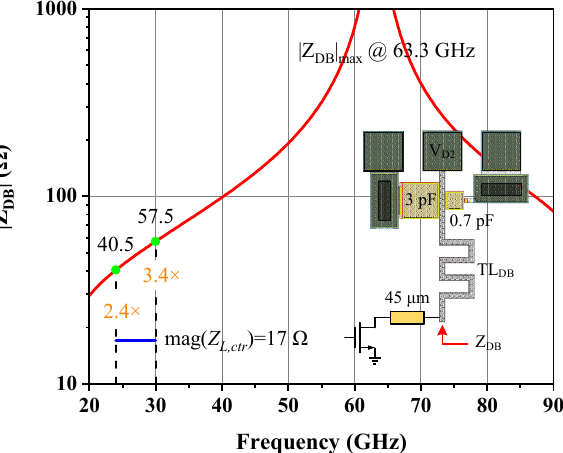
Figure 8. Drain bias network used in the output stage and its equivalent input impedance. Figure 9 shows how the response curve of the OMN rotates with the frequency inside the predefined optimal impedance domain and forms a knot signifying broadband match- ing, the junction of which corresponds to frequencies of 24 GHz and 31.5 GHz. Although the 22–32 GHz trajectory fails to sandwich Z L,ctr perfectly, it manages to fall into the nar- row, preferred matching region as a whole, and the impedance at 32 GHz highly coincides with Z L,ctr , implying that the DA’s performance at the high-end fundamental is well se- cured and will not sharply deteriorate there. Furthermore, the second and third harmonic impedances exhibit relatively widespread scattering alongside the Smith chart’s margin, but neither are located in the aforementioned phase avoidance interval and therefore do not require extra harmonic manipulation.